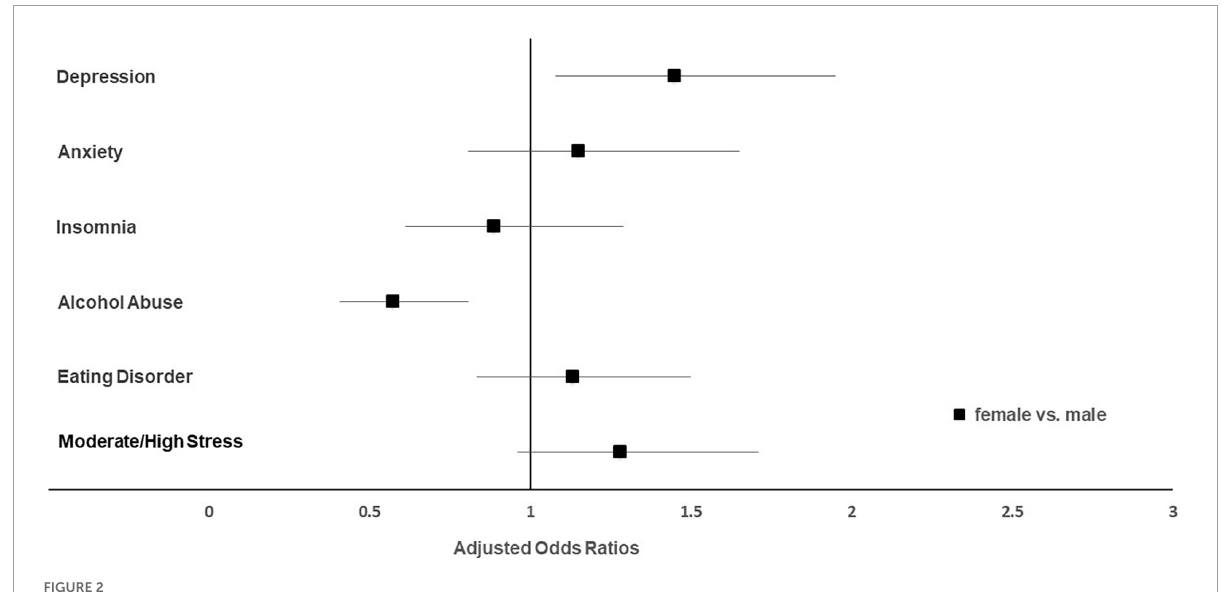
FIGURE2 Adjusted odds ratios stratified by gender with the category “male” being the reference.